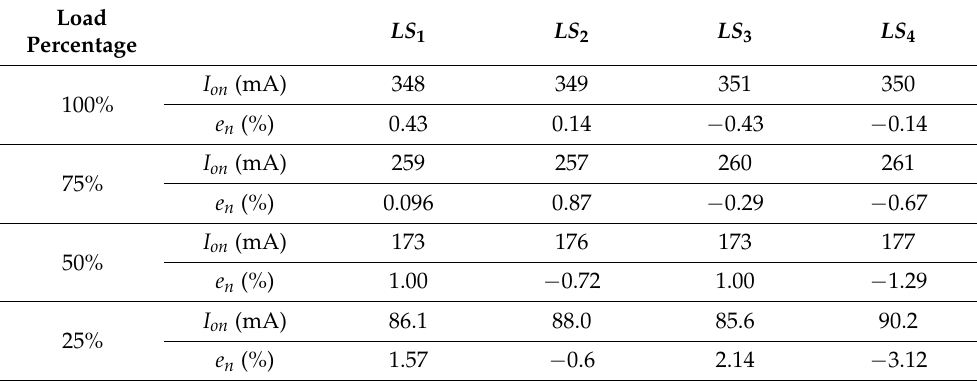
Table 5. Current error percentage under different loads.